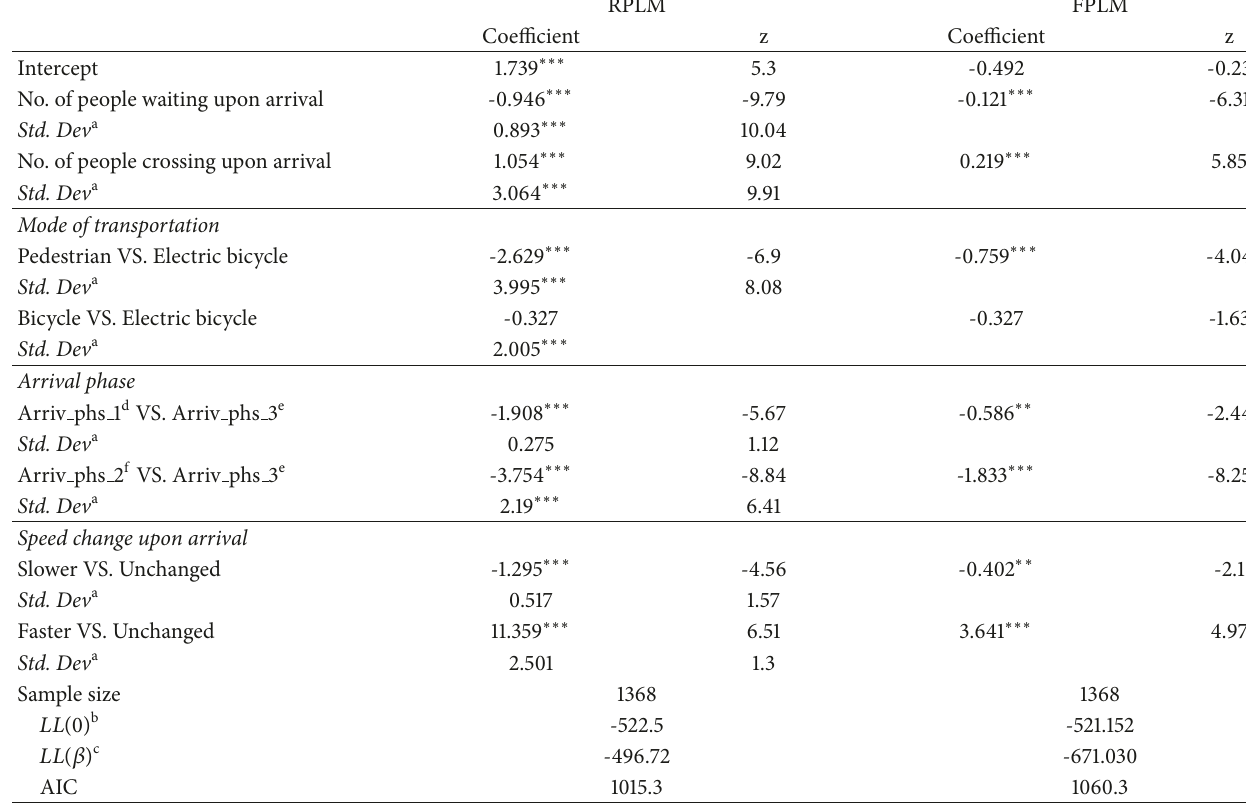
Table 4: Summary of random and fixed parameter logit models estimation results for IRLR behaviour.